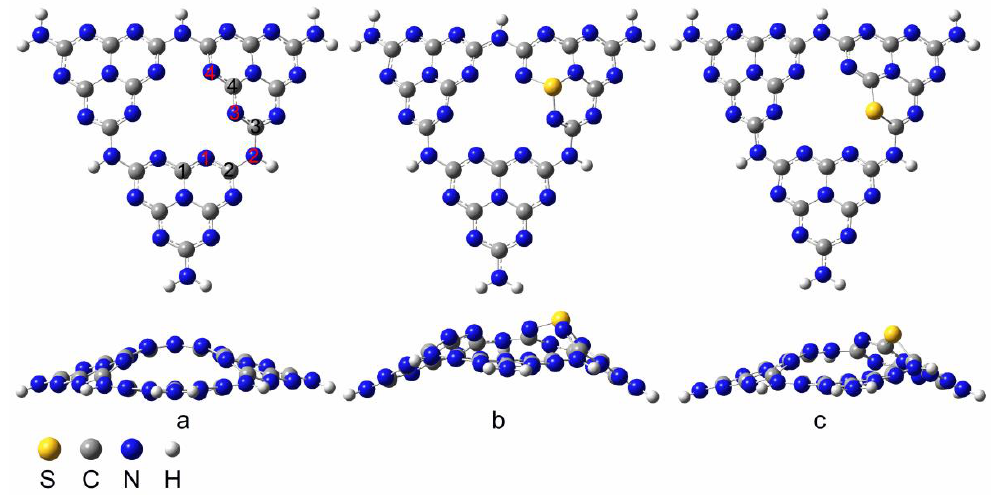
Figure 1. Top and side views of the most stable configurations of g-C 3 N 4 ( a ) and S-doped g-C 3 N 4 ( b , c